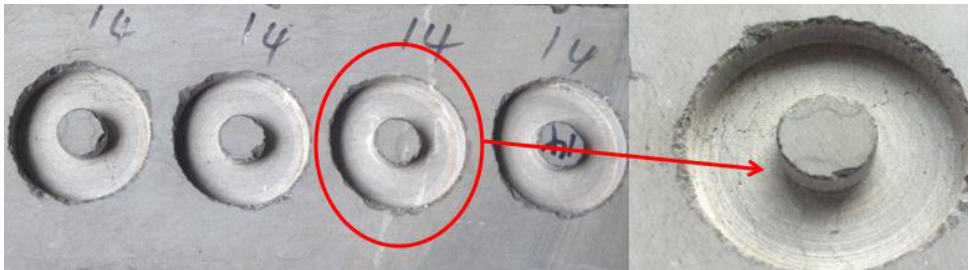
Figure 7. The limestone micro bottom